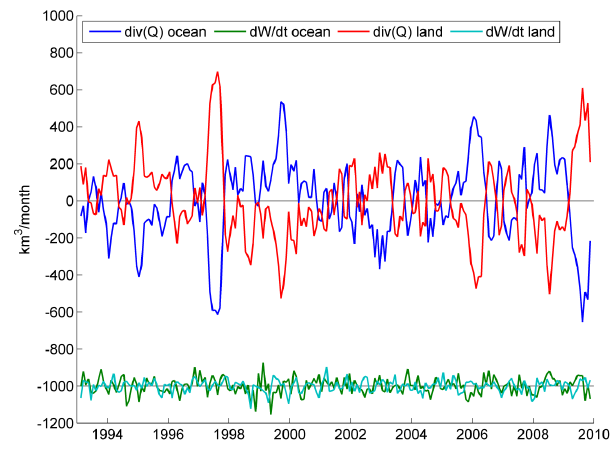
Fig. 7. Components of the atmospheric water budget. Spatial mean Figure 7: Components of the atmospheric water budget. Spatial mean over ocean and land. 3 over ocean and land. The dW/ d t time series are shifted vertically The dW/dt time series are shifted vertically for clarity. 4 for clarity. 5